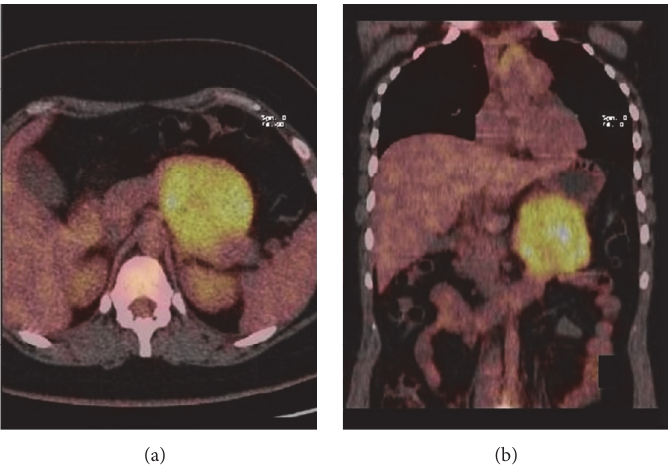
Figure 2: Positron emission tomography with CT acquisition (PET/CT)of the abdomen: axial (a) and coronal image (b) showing a pathologic uptake of FDG in a well-circumscribed, round mass in the tail of the pancreas (case number 15).